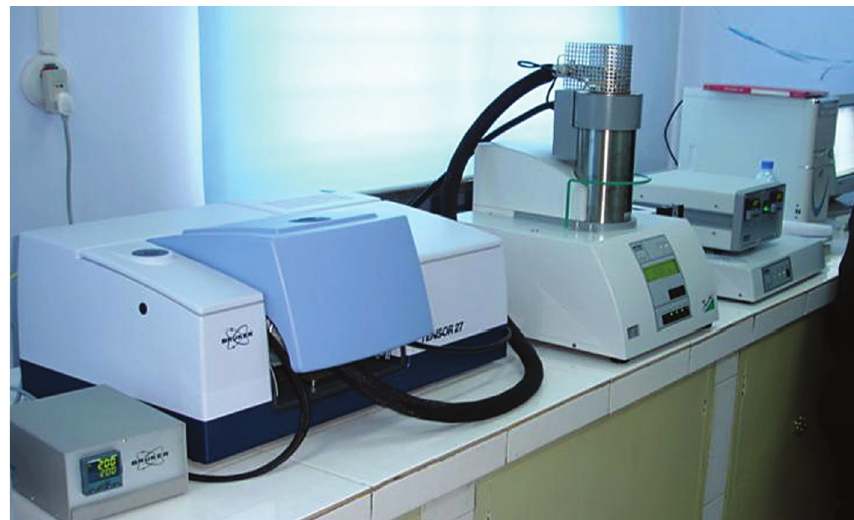
Figure 5: Thermogravimetric analyzer test system.